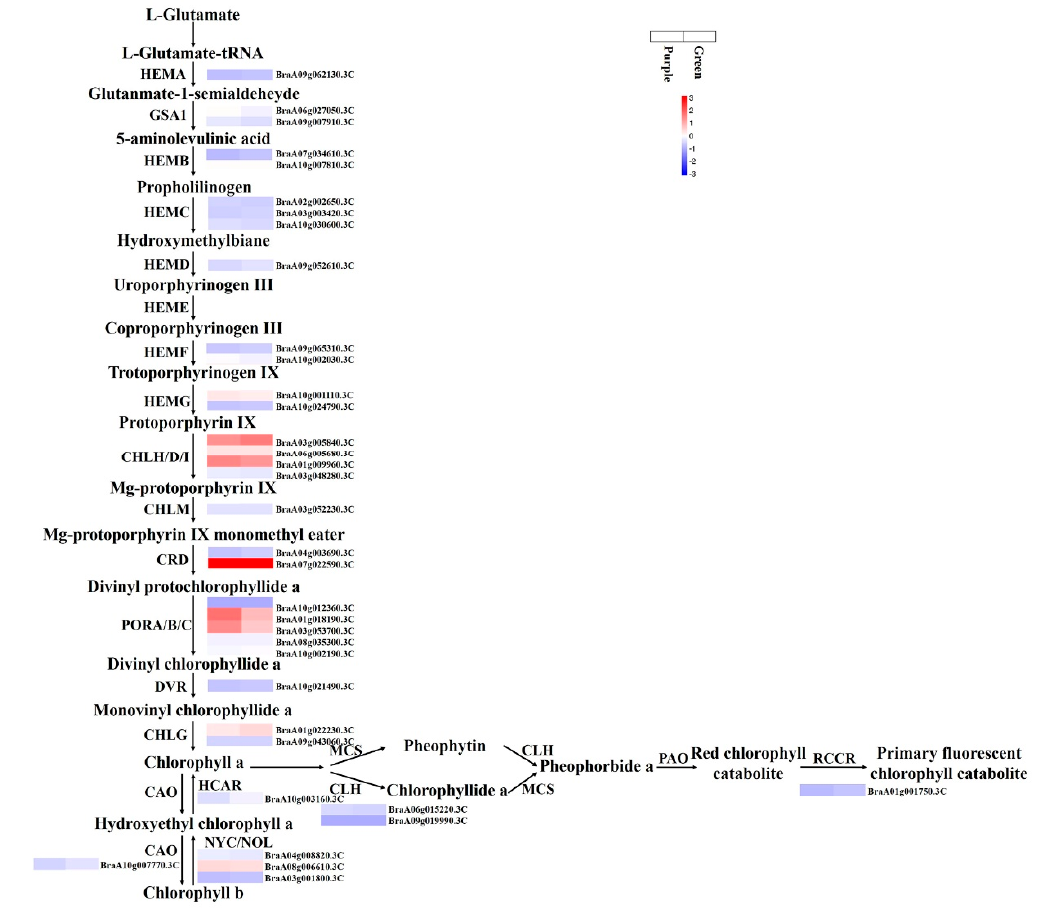
Figure 7. Chlorophyll biosynthetic pathway in non-heading Chinese cabbage.